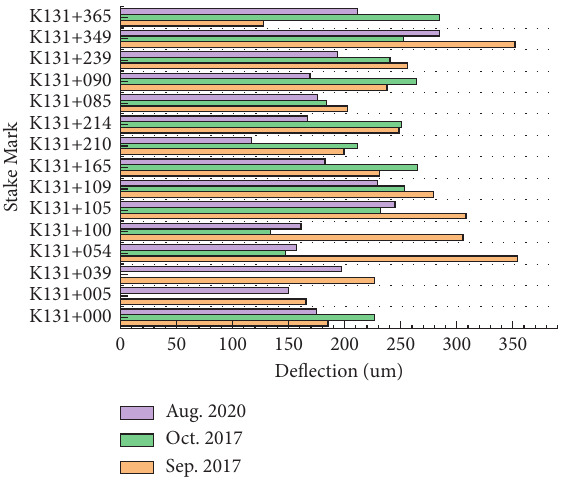
Figure 19: Comparison of average deflections measured in three tests with a 9T